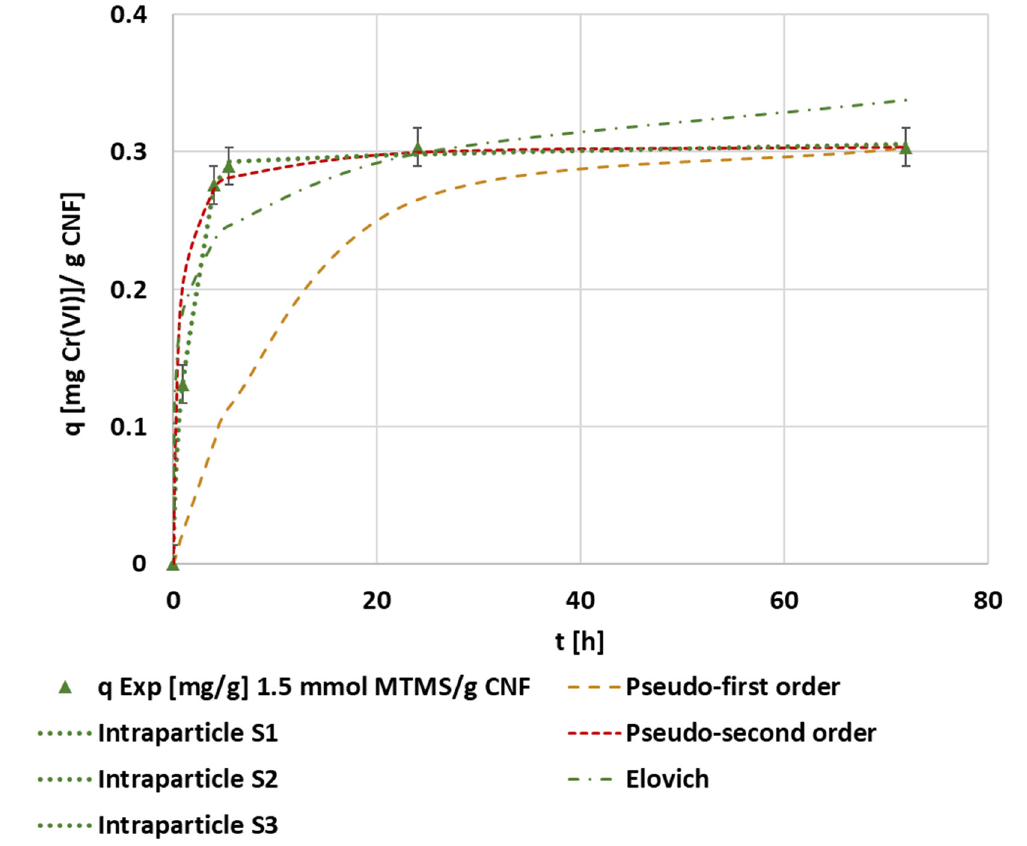
Figure 2. The evolution of the kinetic adsorption experiment at 0.1 mg·L − 1 of the initial chromium concentration, pH 3, and 1000 mg CNF·L − 1 hydrophobized with 1.5 mmol MTMS·g − 1 cellulose and kinetic fitting of the pseudo-first, pseudo-second, Elovich, and intraparticle models.